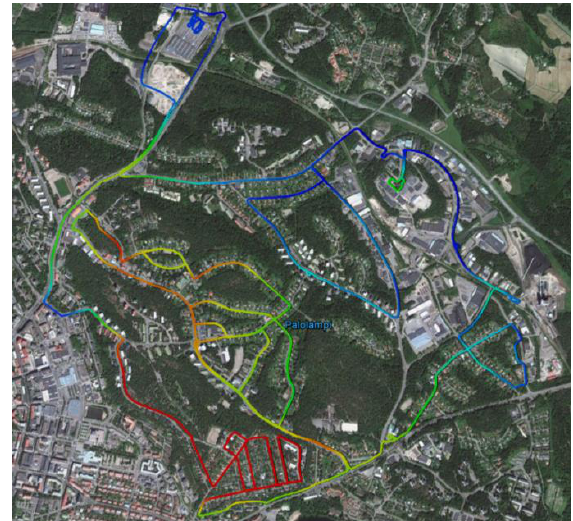
Figure 1. ALS test field area in the city of Lahti. Elevation coloured MLS trajectory shows the current MLS reference data coverage (background image: Google Maps).